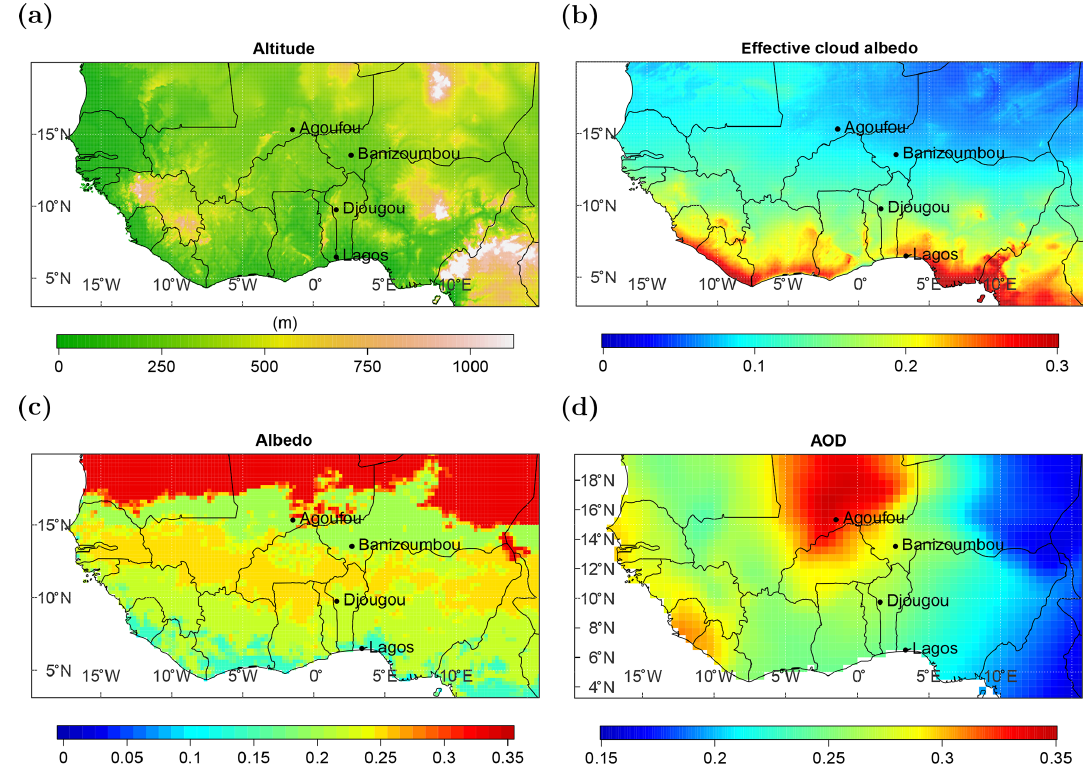
Figure 1. ( a ) Topography of the region considered (Global Land One-km Base Elevation Project, GLOBE, database; Hastings and Dunbar, 1999), ( b ) mean cloud albedo between 1983 and 2017 (from the SARAH-2.1 data set described in Sect. 2.1), ( c ) albedo climatology (Surface and Atmospheric Radiation Budget, SARB, data from Clouds and the Earth’s Radiant Energy System, CERES) and ( d ) aerosol optical depth climatology (European Center for Medium Range Weather Forecast, Monitoring Atmospheric Composition and Climate, MACC). The locations of the three ground-based sites (Agoufou, Banizoumbou and Djougou) and the additional location used for the time series analysis in Sect. 5.2 (Lagos) are